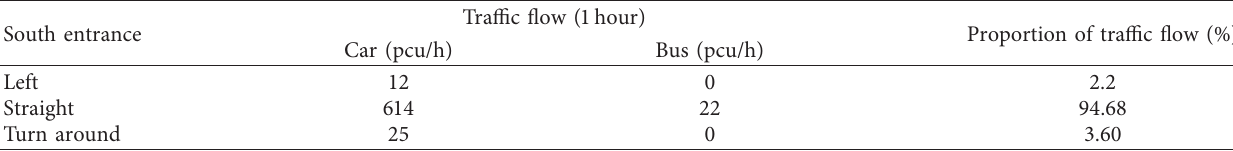
Table 8: Morning peak hour traffic flow near the school.